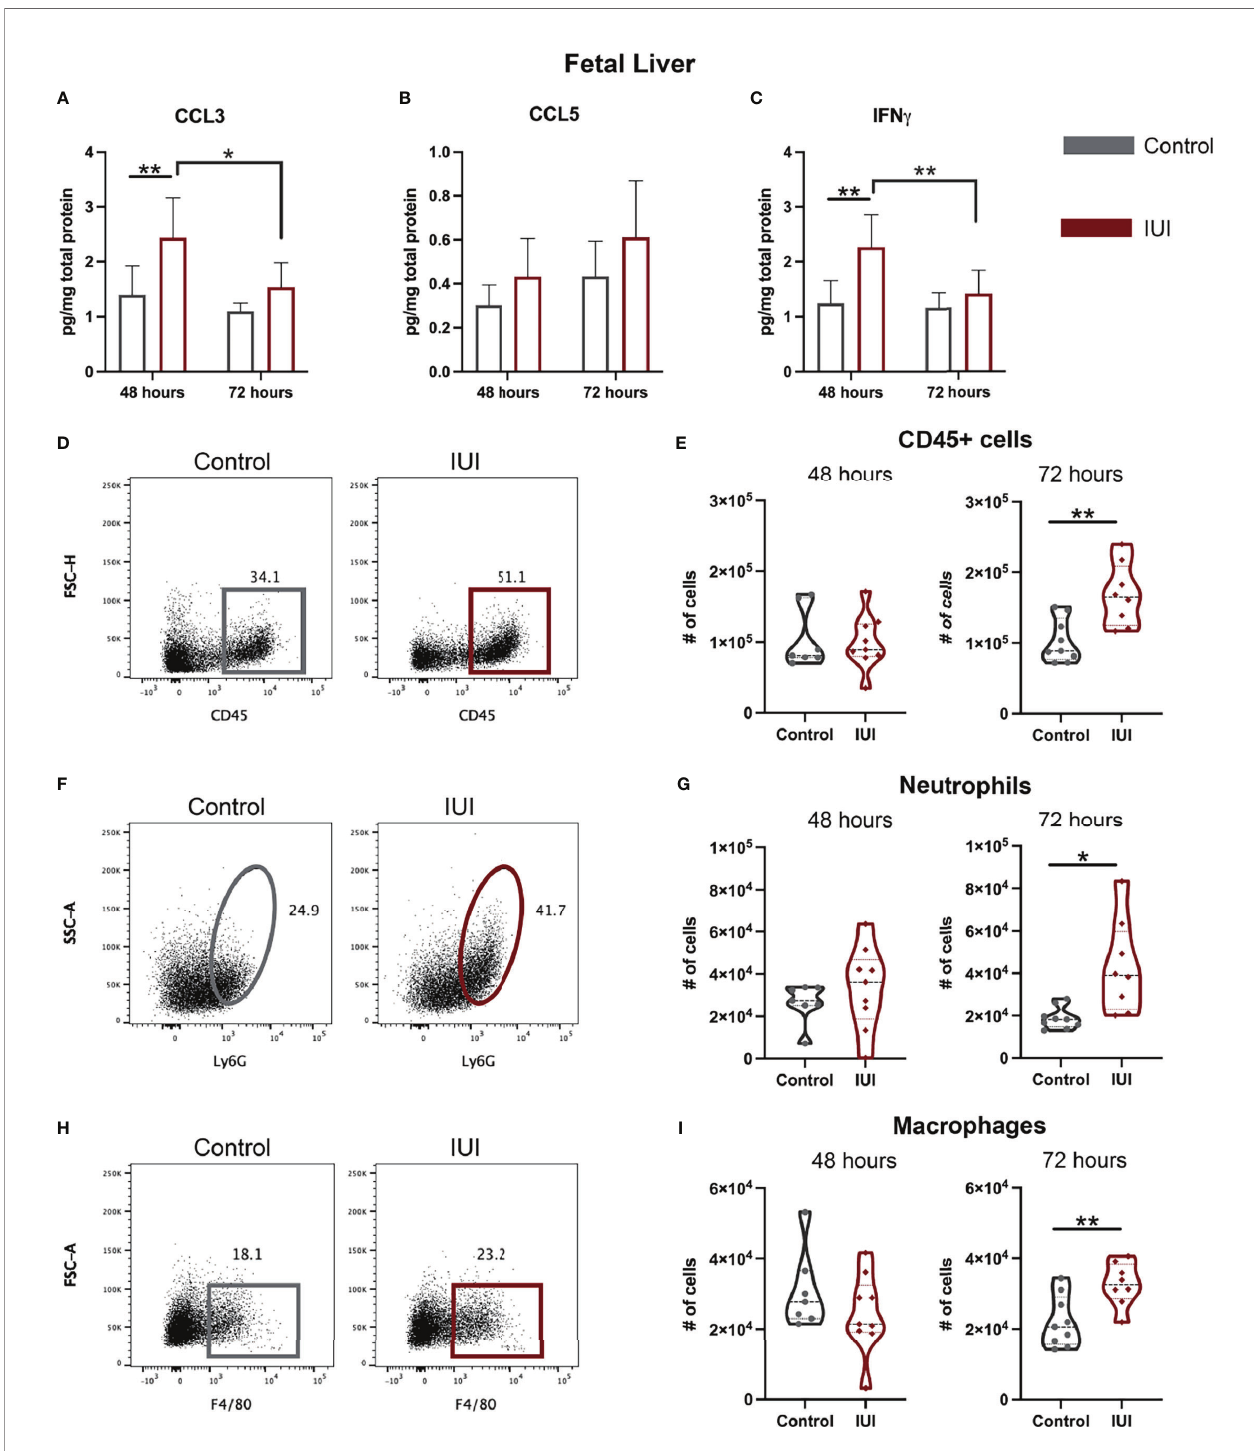
FIGURE 4 | Neutrophil and cytokine elevation in the fetal liver demonstrate systemic fetal in fl ammation. Fetal livers were collected at 48 and 72 hours post-uterine injection and either frozen or processed for fl ow cytometry. (A – C) Frozen fetal livers were tested for cytokines by ELISA and normalized to total protein. Fresh fetal livers were analyzed by fl ow cytometry for immune cells. (D, E) Total CD45+ cells, (F, G) neutrophil, and (H, I) macrophage cell counts are shown. (D) Representative fl ow plots of CD45+ cells were gated on non-debris, singlet, live cells. (F) Representative fl ow plots of neutrophils were gated on non-debris, singlet, live, CD45+, CD3-, CD19- cells. (H) Representative fl ow plots of macrophages were gated on non-debris, singlet, live, CD45+, CD3-, CD19- cells. Cell count data was analyzed by Mann-Whitney test. Cytokine data were analyzed by two-way ANOVA with post-hoc Tukey ’ s multiple comparison test. *p<0.05,